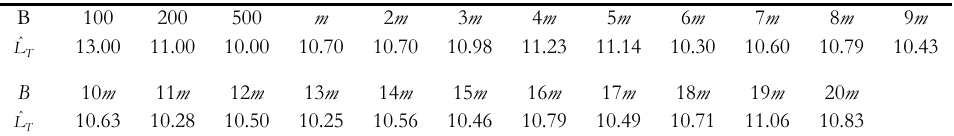
First application: resulting estimated percent p-values